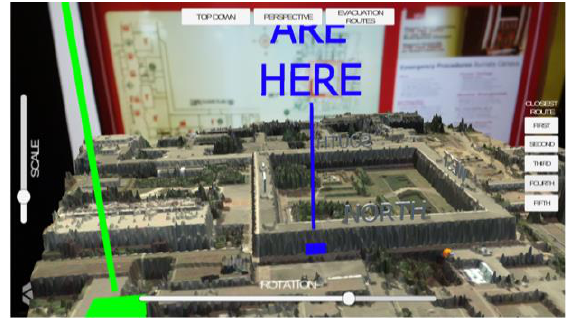
Figure 7. Spatially contextualized emergency exit locations